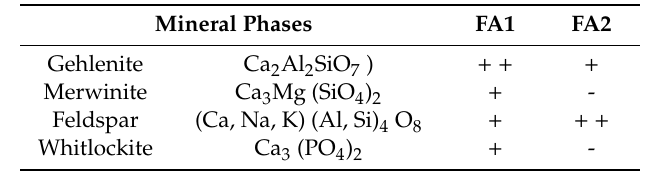
Table 2. Mineralogical analysis (XRD) of fly ash samples.